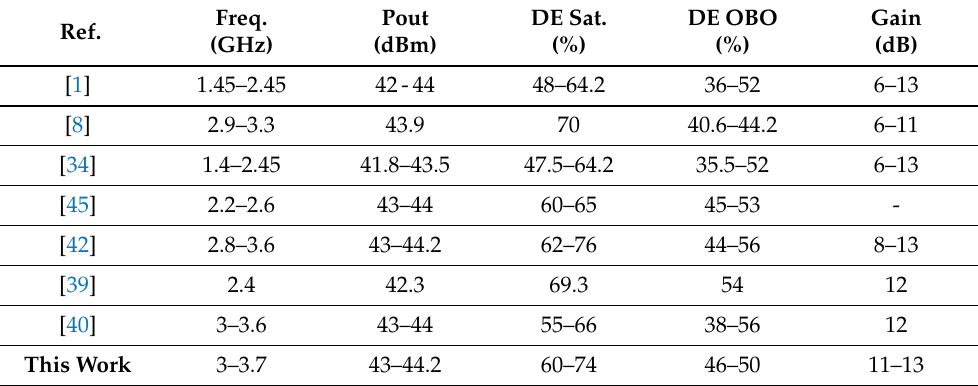
Table 2. Comparison of the proposed class-J DPA with the literature: only designs based on the same CGH40010F device are considered. Ref.